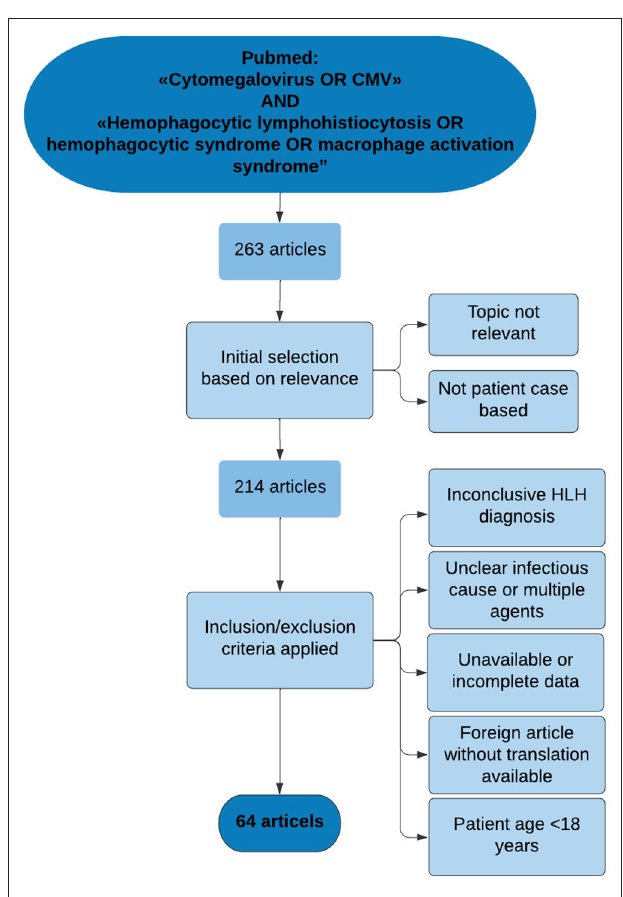
FIGURE 3 | Flow chart of literature search process. The search and elimination process illustrated by a flow chart. The search led to 64 articles describing patient cases of CMV-associated HLH. Six of the articles described more than one relevant patient case. In total, 73 patient cases were included from literature.